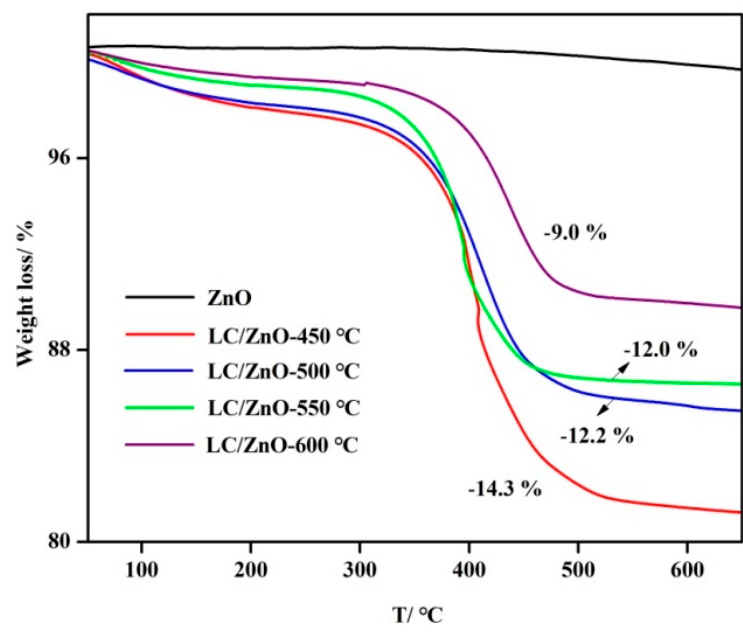
Figure 4. TG image of LC/ZnO composite.